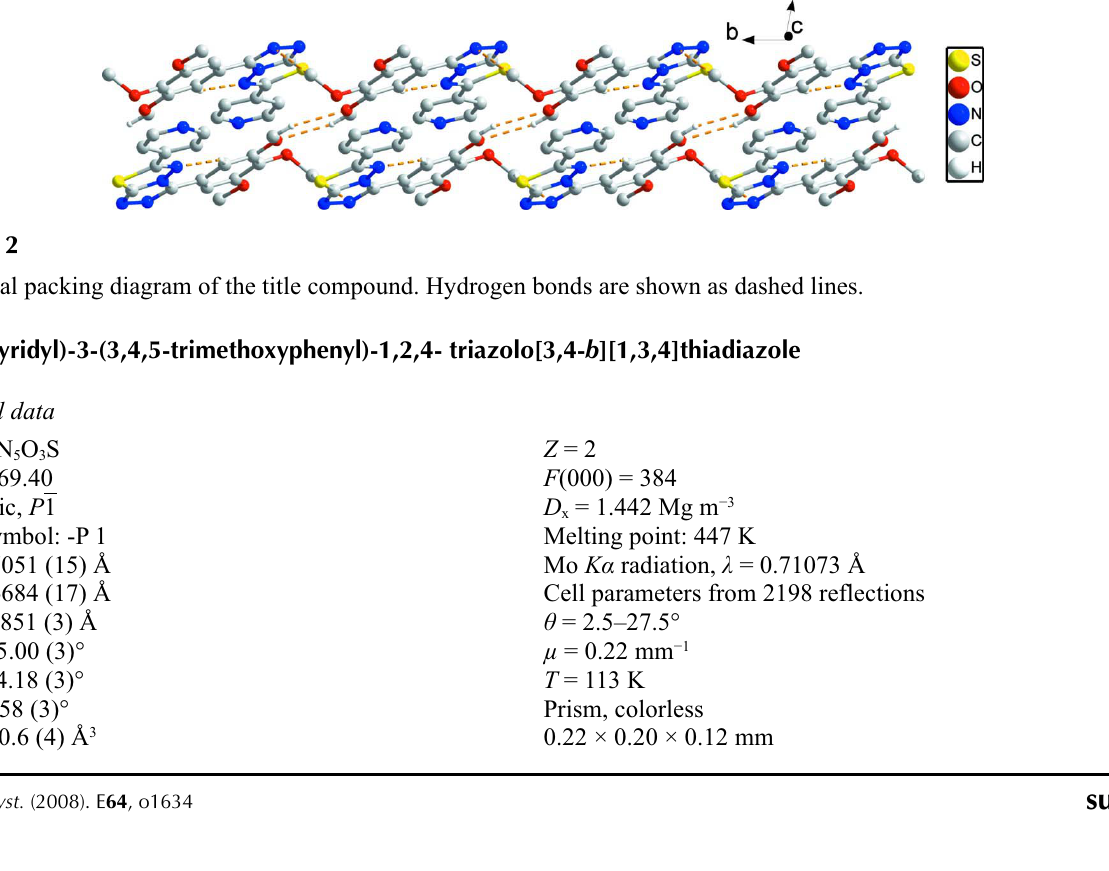
The molecular structure of the title molecule, with the atom-numbering scheme. Displacement ellipsoids are drawn at the 50% probability level.